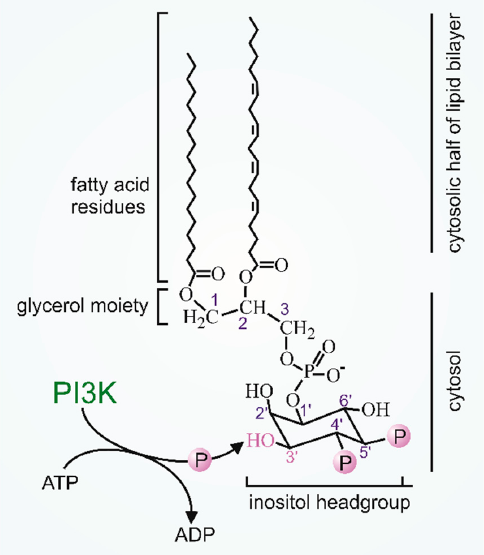
Figure 1. Schematic representation of the PI3K lipid kinase activity. Activation of membrane-associated class I PI3Ks results in phosphorylation of the 3-hydroxyl position of inositol ring in Ptd-4,5-P 2 generating the essential second messenger of the plasma membrane, Ptd-3,4,5-P 3 .